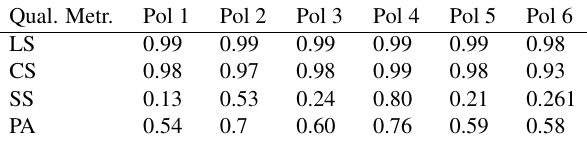
Table 4. Calculated quality measures for each